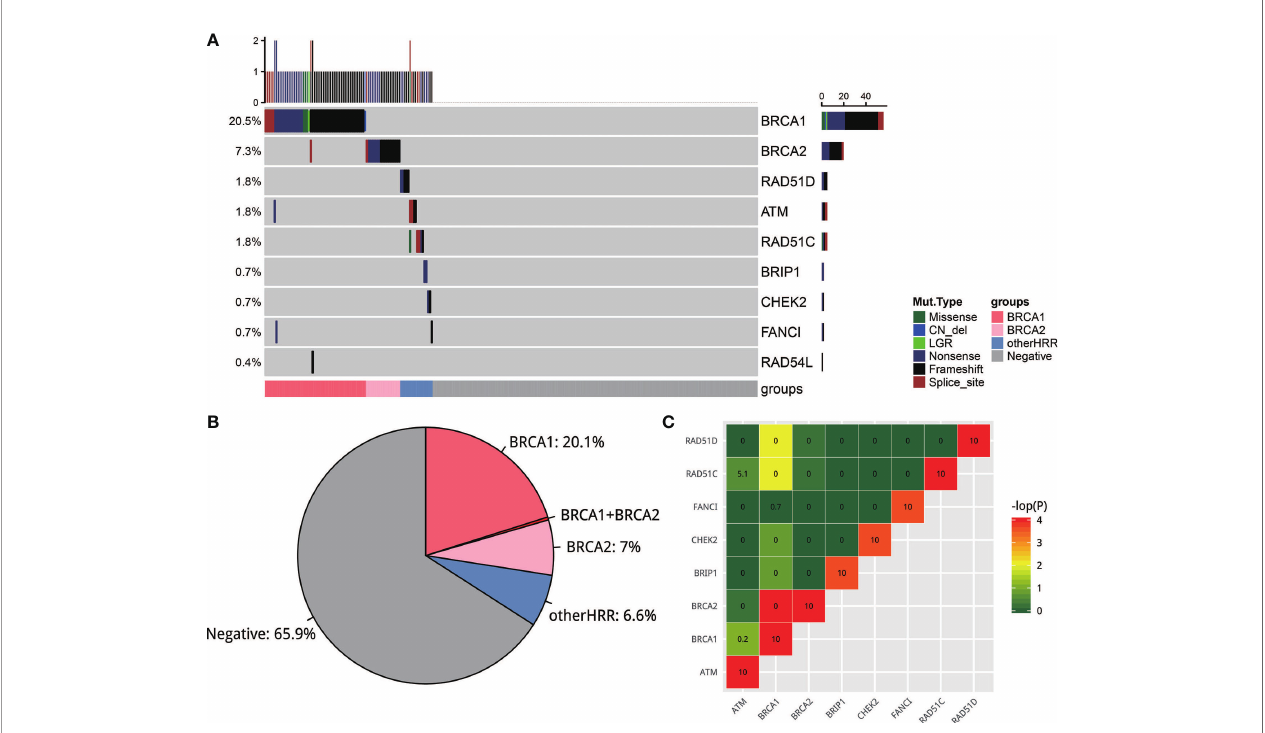
FIGURE 2 | (A) The mutation landscape of homologous recombination repair (HRR) gene in EOC. Seven of the 13 well-known HRR genes were mutated. (B) Pie plot of the distribution of carriers of HRR genes. (C) Strong mutual exclusion between HR genes. The closer the color is to green or the smaller the number is, the more mutually exclusive the gene mutations are. The closer the color is to red or the larger the number is, the more mutually exclusive the gene mutations are.